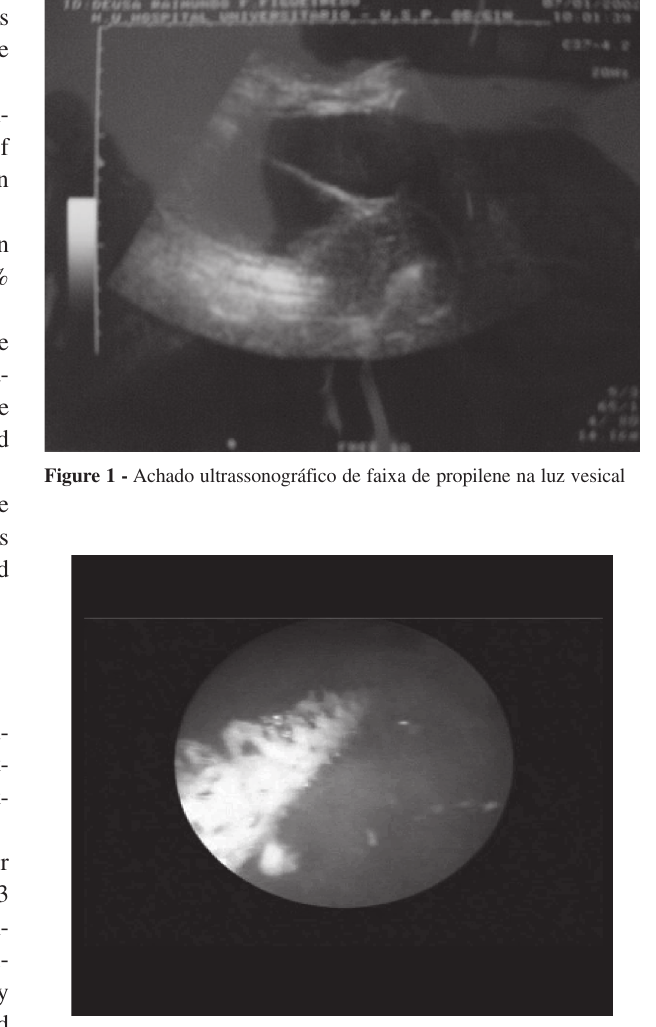
Figure 2 - Visão endoscópica com faixa de propilene intra